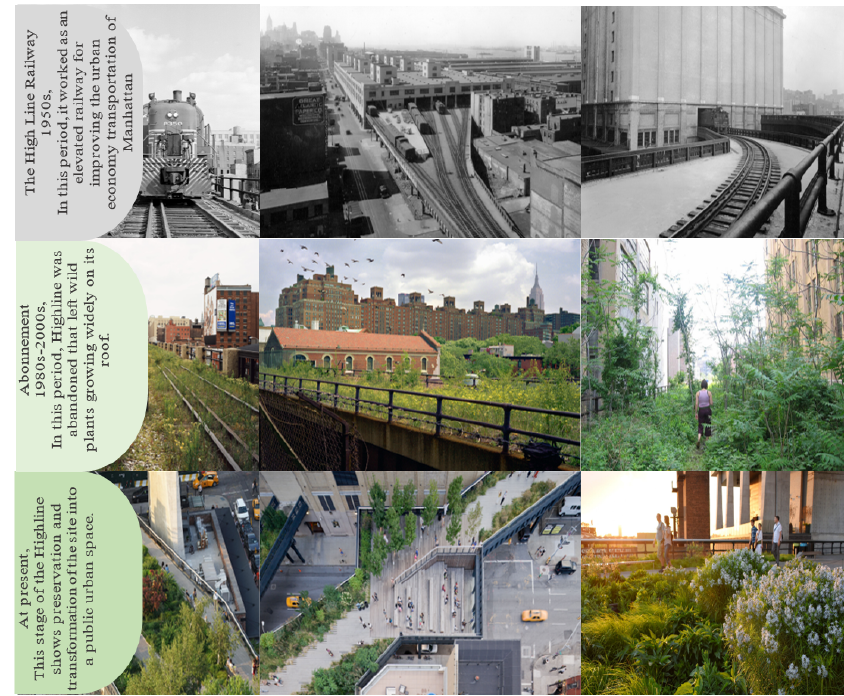
Figure 2. History of the High Line in different historical stages. Data from source: [49].